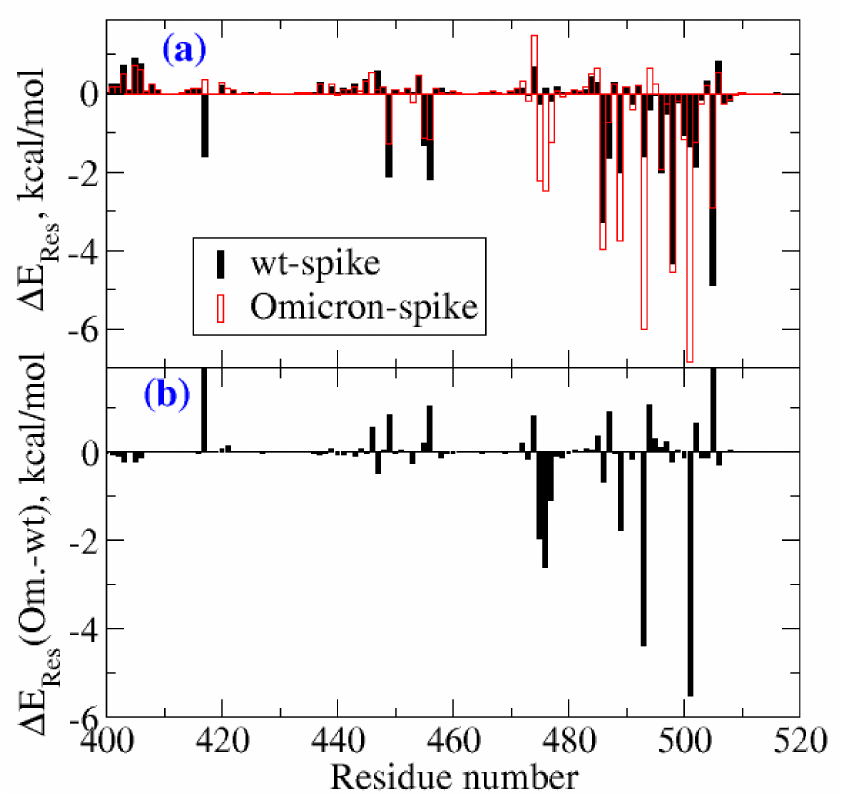
Figure 3. ( a ) Residue-wise contributions for the binding free energies. The results are shown only for residues in the RBD of the spike protein. Further, the numbering of residues is shifted by three for the Omicron to account for the three deletions. ( b ) The difference in residue-wise contributions to the binding free energies between the spike proteins of the Omicron variant and the wild type